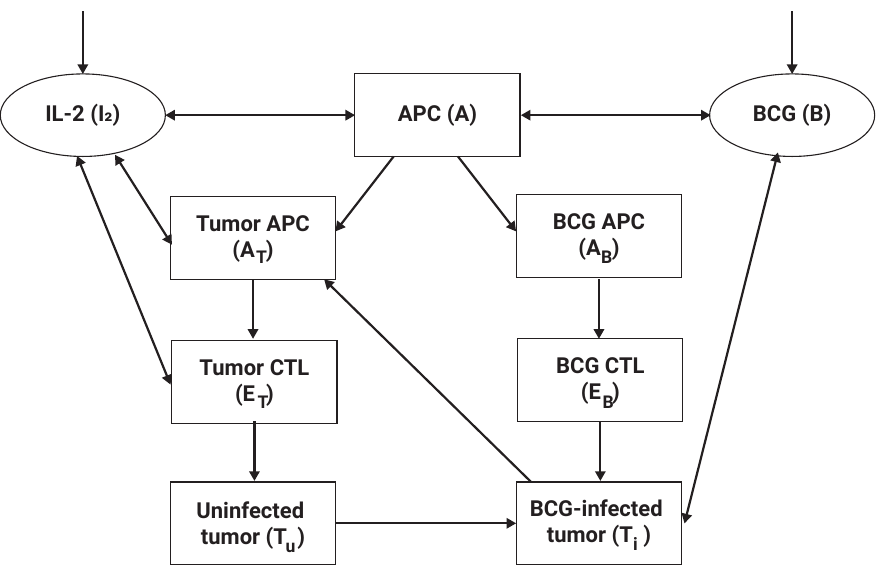
Figure 1. Our schematic view of the biological model proposed by [22]. Table 1. The model’s parameter definitions and average values as adopted from